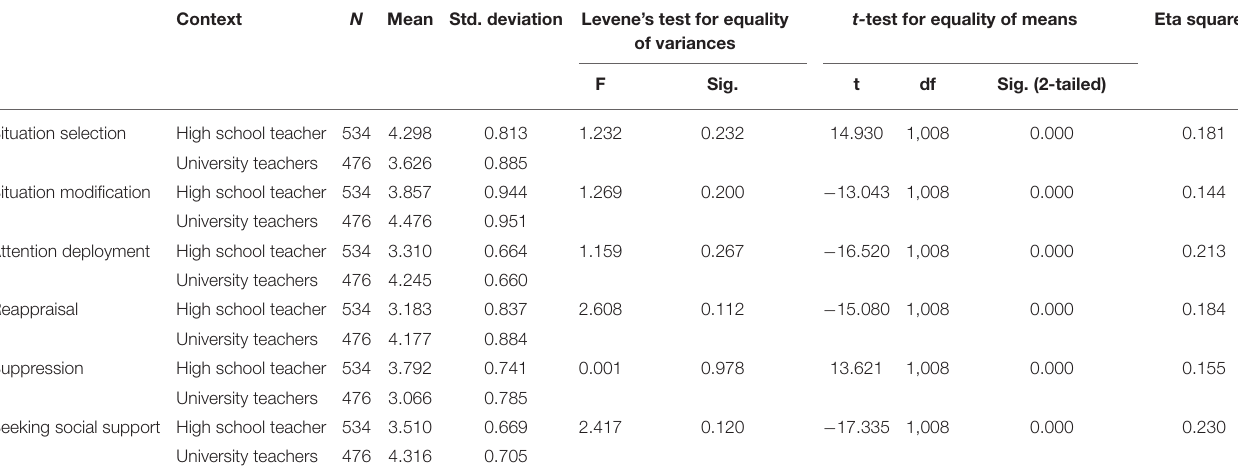
TABLE 9 | Independent samples t -test: high school vs. university teachers regarding their emotion regulation at workplace. Context N Mean Std. deviation Levene’s test for equality of